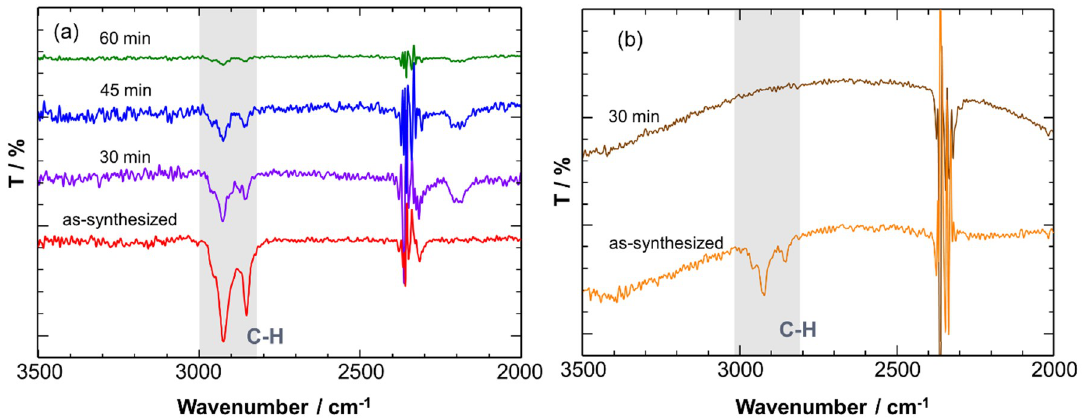
Figure 7. FT-IR spectra of ( a ) Cu 2 O and ( b ) CuO NCs heated at 200 and 250 °C, respectively, in air for different times.